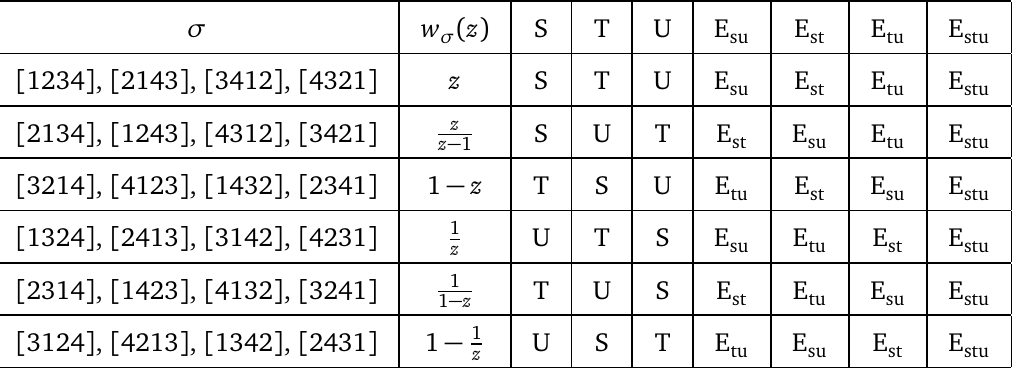
transformation between classes and 4